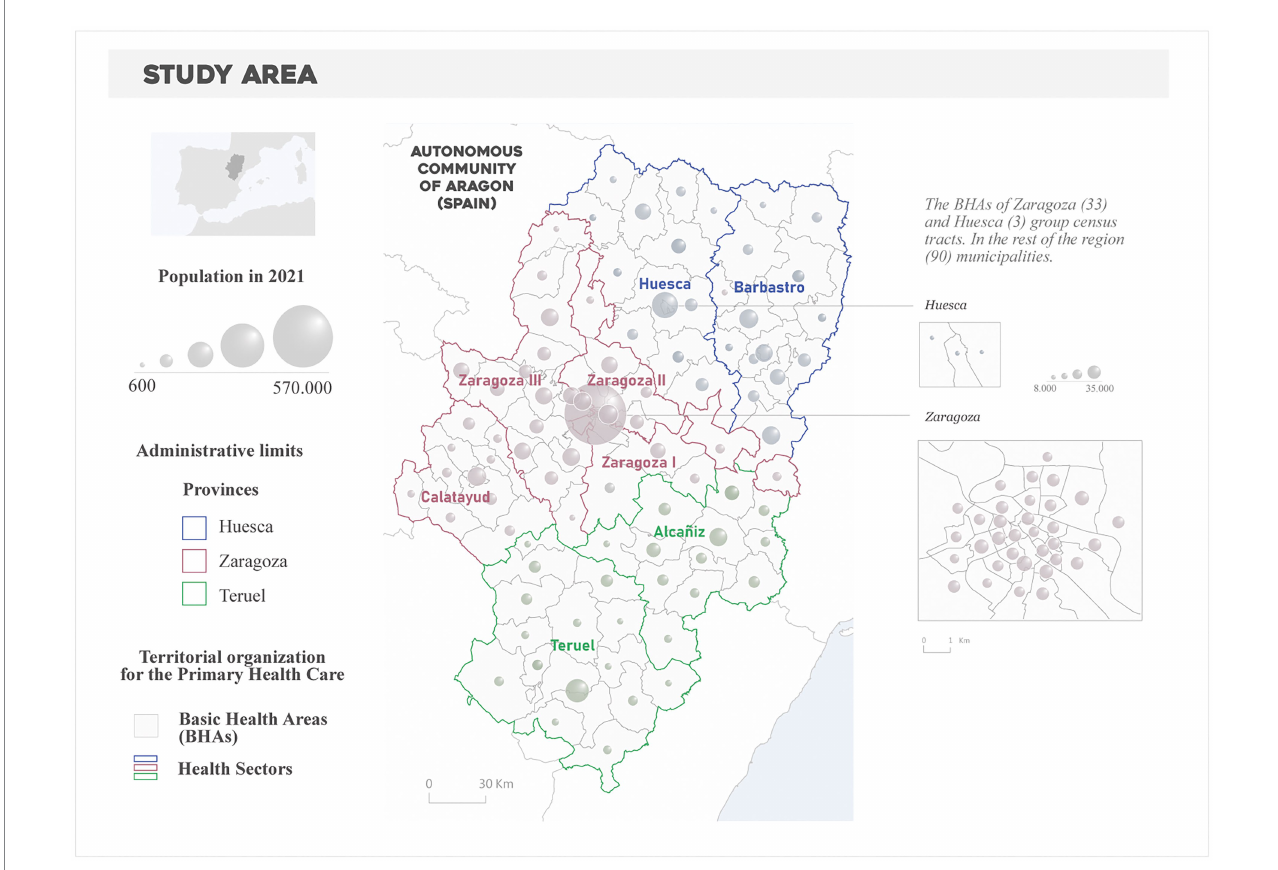
FIGURE 1 Study area. Territorial organization of the Primary Health Care in